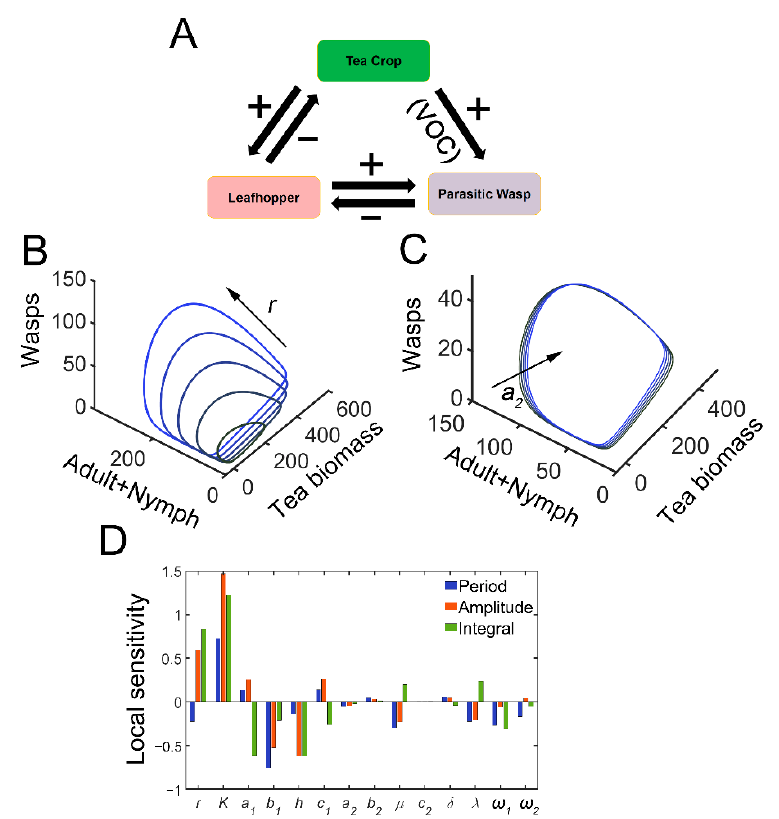
Figure 1. Tritrophic interactions exhibit sustained oscillations. ( A ) Schematic diagram of tritrophic relationship among tea crops, TGLs, and natural enemies (parasitic wasps). The feeding damage by TGLs induces the release of volatiles, which can attract the wasps. ( B ) Limit cycles in 3D plot with increasing growth rate of tea crops ( r ). In the simulation, r is increased from 4 to 12, with an increment of 2. ( C ) Limit cycles in 3D plot with increasing parasitic rate ( a 2 ). a 2 is increased from 0.4 to 2, by 0.4. ( D ) Local sensitivity analysis for period (blue), amplitude (red), and integrated tea crop levels (green, integral, or tea yields).